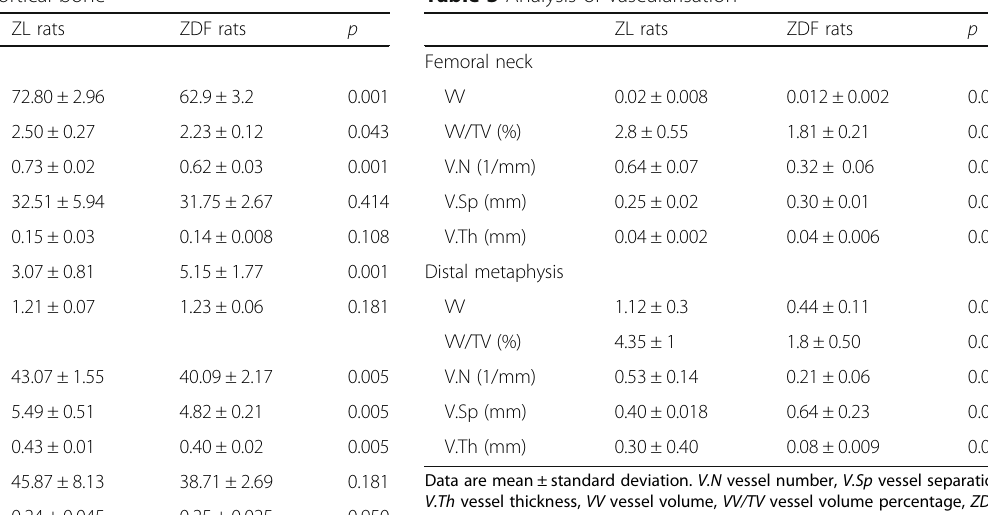
Table 3 Analysis of